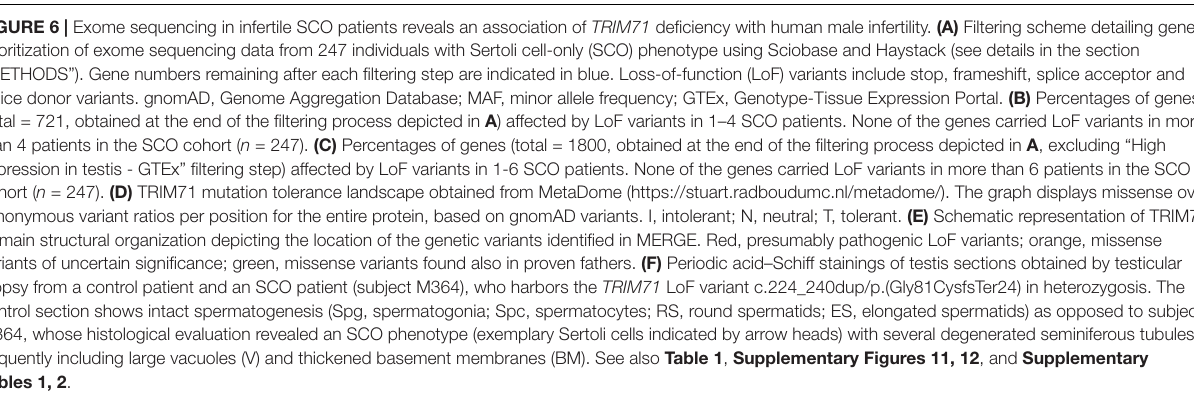
FIGURE 6 | Exome sequencing in infertile SCO patients reveals an association of TRIM71 deficiency with human male infertility. (A) Filtering scheme detailing gene prioritization of exome sequencing data from 247 individuals with Sertoli cell-only (SCO) phenotype using Sciobase and Haystack (see details in the section “METHODS”). Gene numbers remaining after each filtering step are indicated in blue. Loss-of-function (LoF) variants include stop, frameshift, splice acceptor and splice donor variants. gnomAD, Genome Aggregation Database; MAF, minor allele frequency; GTEx, Genotype-Tissue Expression Portal. (B) Percentages of genes (total = 721, obtained at the end of the filtering process depicted in A ) affected by LoF variants in 1–4 SCO patients. None of the genes carried LoF variants in more than 4 patients in the SCO cohort ( n = 247). (C) Percentages of genes (total = 1800, obtained at the end of the filtering process depicted in A , excluding “High expression in testis - GTEx” filtering step) affected by LoF variants in 1-6 SCO patients. None of the genes carried LoF variants in more than 6 patients in the SCO cohort ( n = 247). (D) TRIM71 mutation tolerance landscape obtained from MetaDome (https://stuart.radboudumc.nl/metadome/). The graph displays missense over synonymous variant ratios per position for the entire protein, based on gnomAD variants. I, intolerant; N, neutral; T, tolerant. (E) Schematic representation of TRIM71 domain structural organization depicting the location of the genetic variants identified in MERGE. Red, presumably pathogenic LoF variants; orange, missense variants of uncertain significance; green, missense variants found also in proven fathers. (F) Periodic acid–Schiff stainings of testis sections obtained by testicular biopsy from a control patient and an SCO patient (subject M364), who harbors the TRIM71 LoF variant c.224_240dup/p.(Gly81CysfsTer24) in heterozygosis. The control section shows intact spermatogenesis (Spg, spermatogonia; Spc, spermatocytes; RS, round spermatids; ES, elongated spermatids) as opposed to subject M364, whose histological evaluation revealed an SCO phenotype (exemplary Sertoli cells indicated by arrow heads) with several degenerated seminiferous tubules, frequently including large vacuoles (V) and thickened basement membranes (BM). See also Table 1 , Supplementary Figures 11, 12 , and Supplementary Tables 1, 2